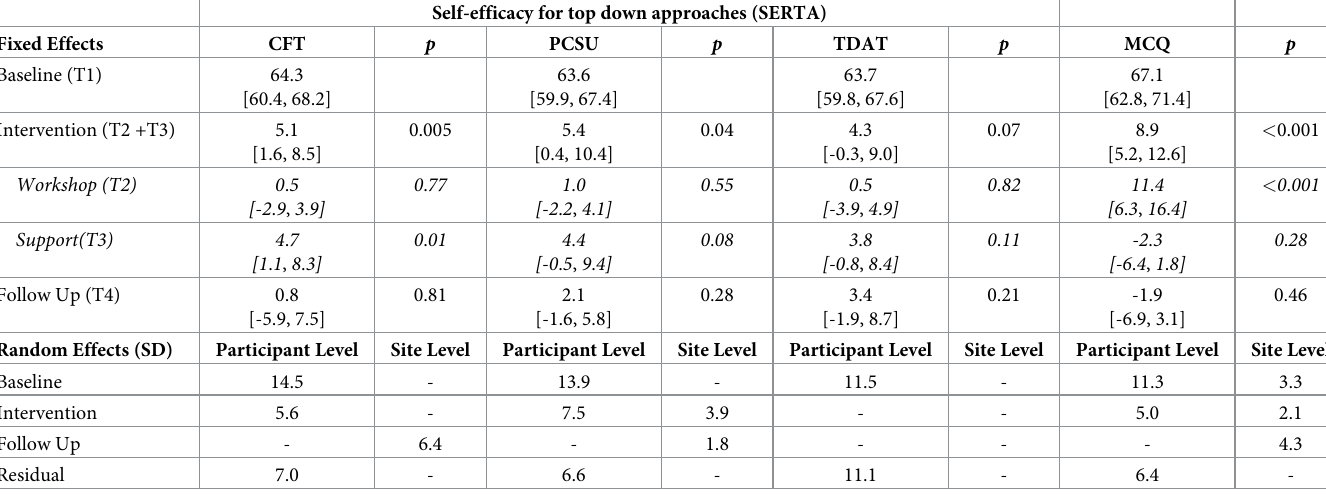
Table 5. Mixed effects models—Fixed effects [and 95% Confidence Intervals] and random effects in SERTA sub-scale domain scores and MCQ